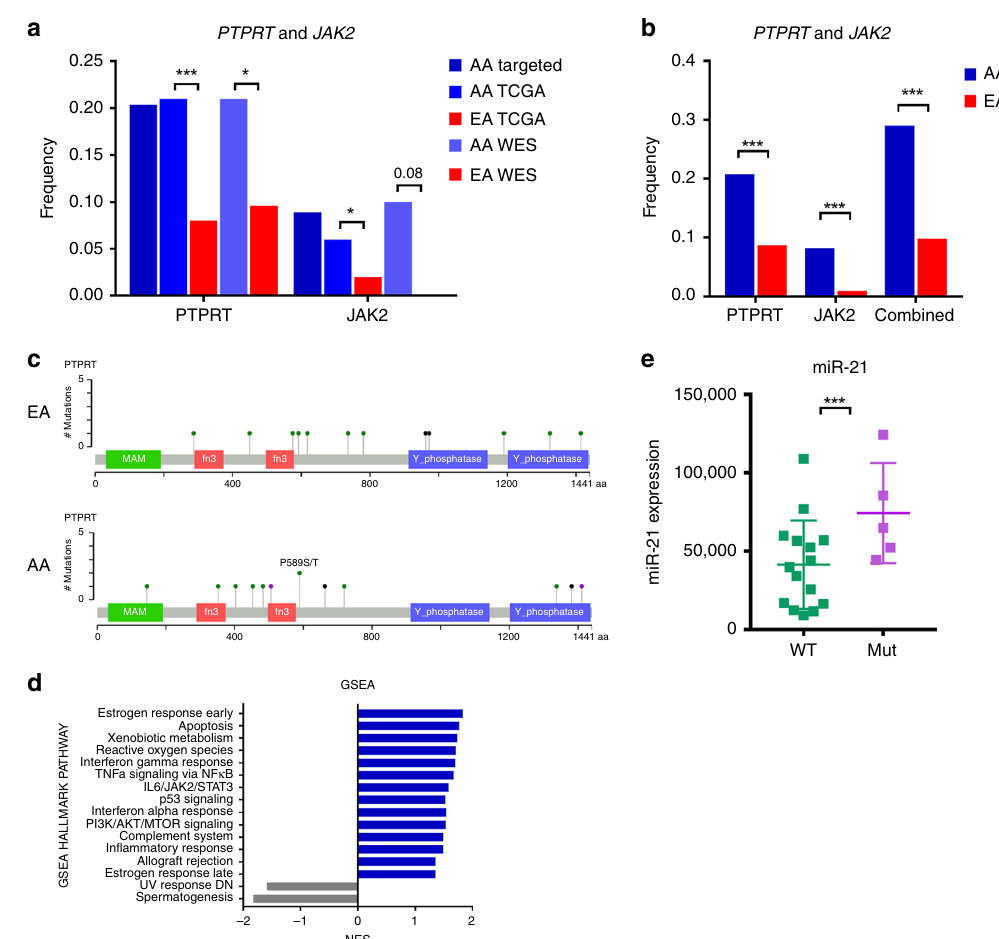
Fig. 2 PTPRT and JAK2 mutations in LUAD. a PTPRT and JAK2 mutations in the NCI-MD Case Control Study using targeted sequencing and WES, and in TCGA using WES and b combined. c Graphical distribution of individual mutations in PTPRT in EAs and AAs. d GSEA of gene expression changes in PTPRT and JAK2 mutant samples compared with wild type. e Levels of miR-21 in PTPRT and JAK2 mutant samples compared with wild type. Error bars indicate the s.d. * P < 0.05, ** P < 0.01, *** P < 0.001, two-sided Student ’ s t -test. Source data are provided as a Source Data fi le. WES, whole-exome sequencing; AA, African American, EA, European American; TCGA, The Cancer Genome Atlas; GSEA, Gene set enrichment